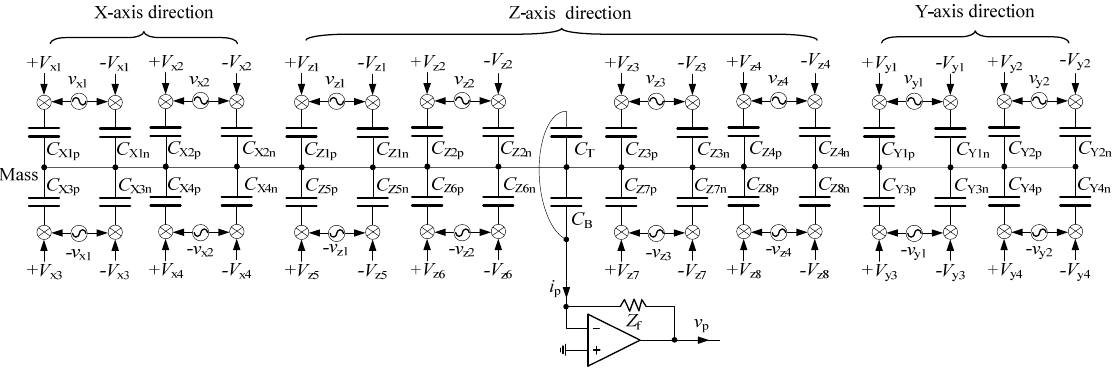
Figure 4. Equvalent capacitive circuits of the micro-accelerometer when common electrodes are used for